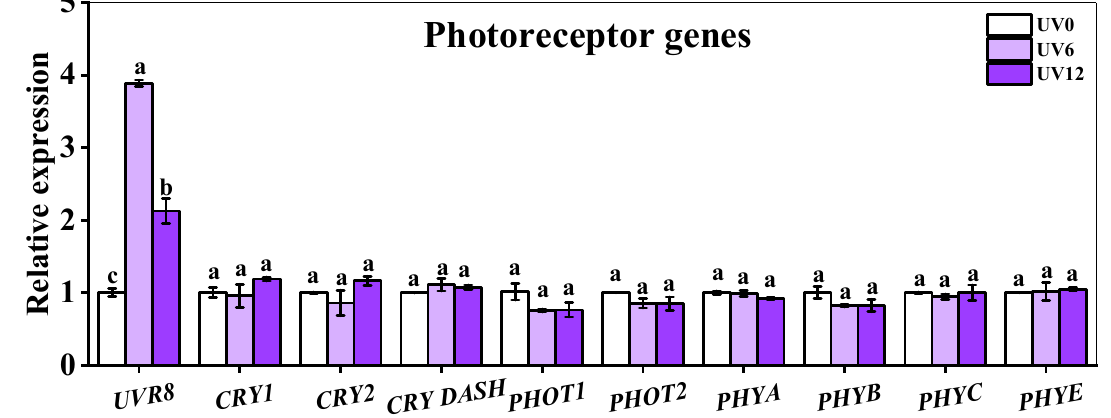
Figure 10. Expressions of photoreceptor genes of Chinese kale subjected to different durations of UVA-radiation exposure. Different lowercase letters (a–c) labeled on the vertical bar (means ± standard error, n = 3) represent significant differences by one-way ANOVA with multiple-range tests ( p ≤ 0.05).